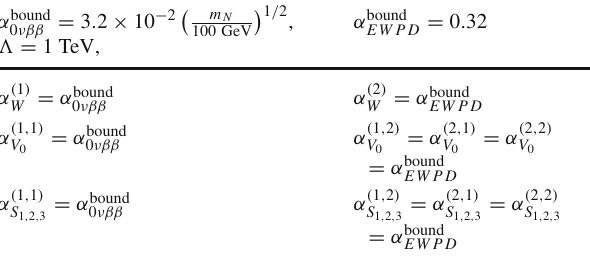
Table 1 Effective couplings numerical